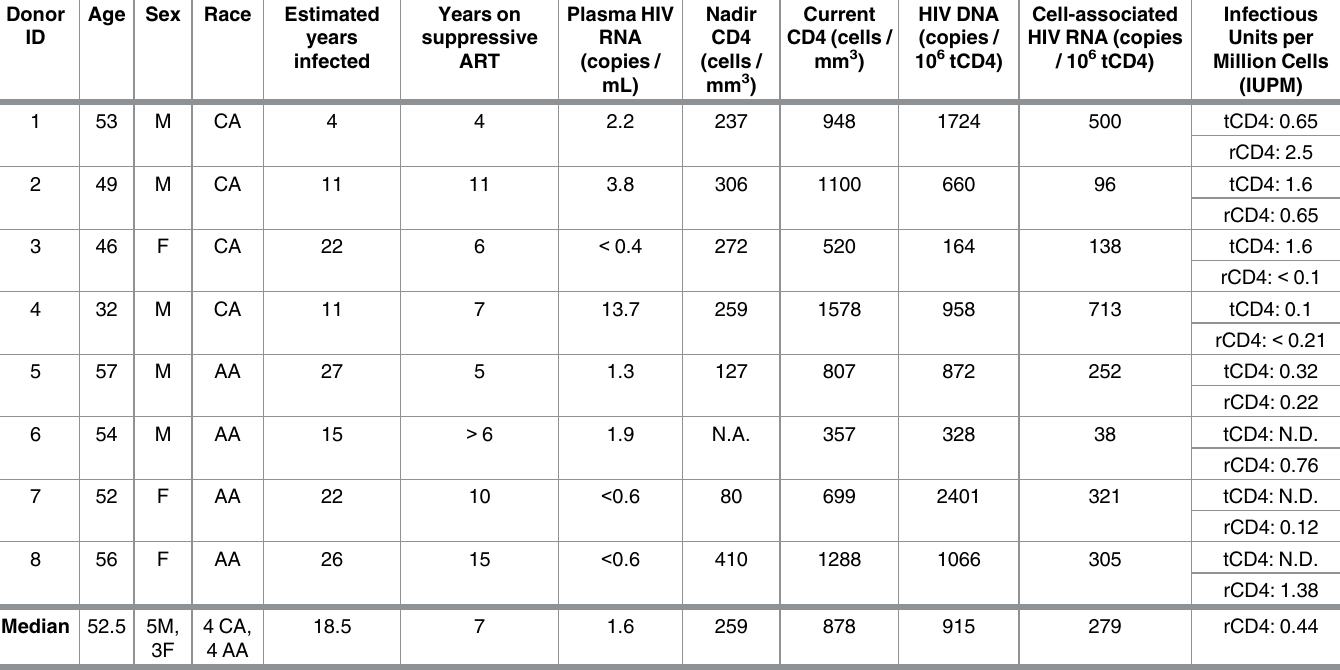
Table 1. Characteristics of Study Donors. Study donors were a convenience sample of eight chronically HIV-1 infected adults on suppressiveART with plasma HIV RNA less than 50 copies/mL for longerthan two